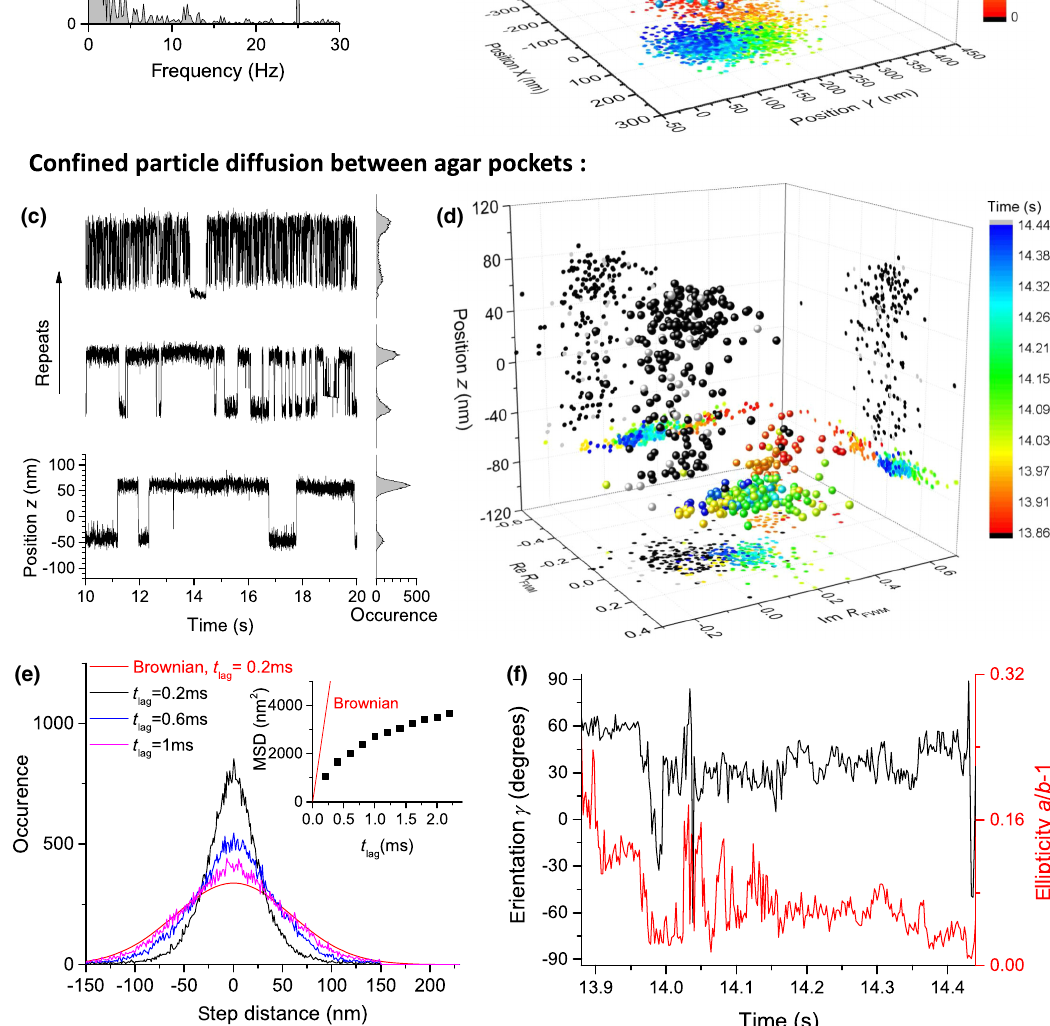
FIG. 7. In situ calibration and nanoparticle tracking. (a) Power spectrum of the FWM field ratio showing the 25 Hz oscillation imposed on the sample stage for calibration, as sketched. (b) Retrieved position coordinates versus time of a single 25 nm radius NP in agar (2 ms per point). (c) Axial-position time traces of a single gold NP while jumping between two gel pockets. (d) Zoom of top trace in panel (c), showing the axial position and FWM field ratio dominated by the NP asymmetry; the corresponding in-plane ellipticity and orientation are shown in panel (f). (e) Analysis of axial-position time traces acquired at 0.2 ms per point (see text). corresponding time evolution of the NP in-plane orientation angle and aspect ratio is given in Fig. 7(f). Finally, Fig. 7(e) shows the analysis from an axial-position time trace acquired at high speed (0.2 ms time per point, for over